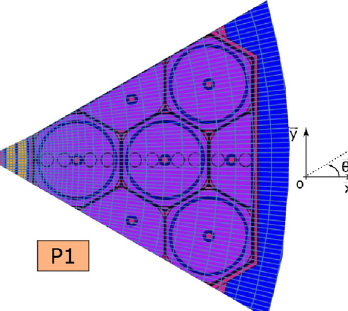
Fig. 4. Fine mesh used for distribution map.